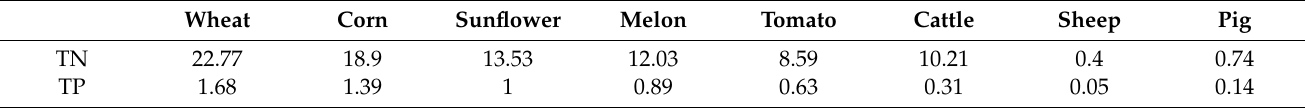
Table 3. Export coefficients (kg/hm 2 /year or kg/ca/year). Wheat Corn Sunflower Melon Tomato Cattle